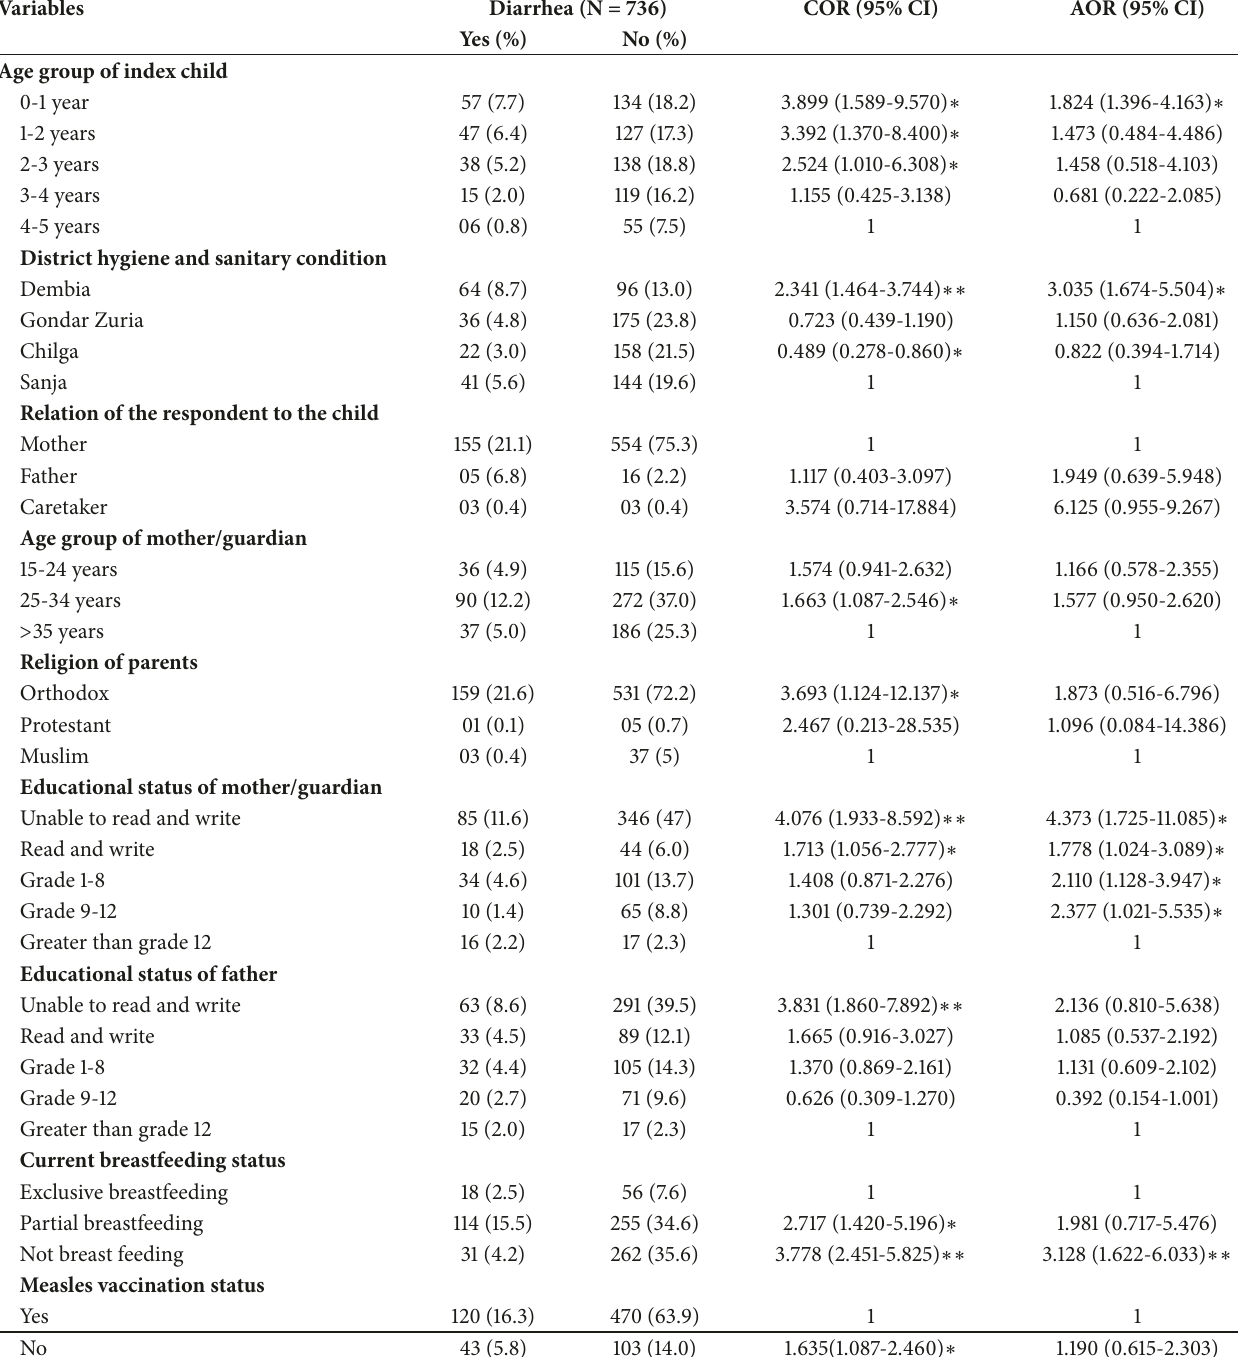
Table 2: Bivariate and multivariate analysis of sociodemographic factors related to diarrhea among under-five children in rural areas of North Gondar Zone, Northwest Ethiopia,